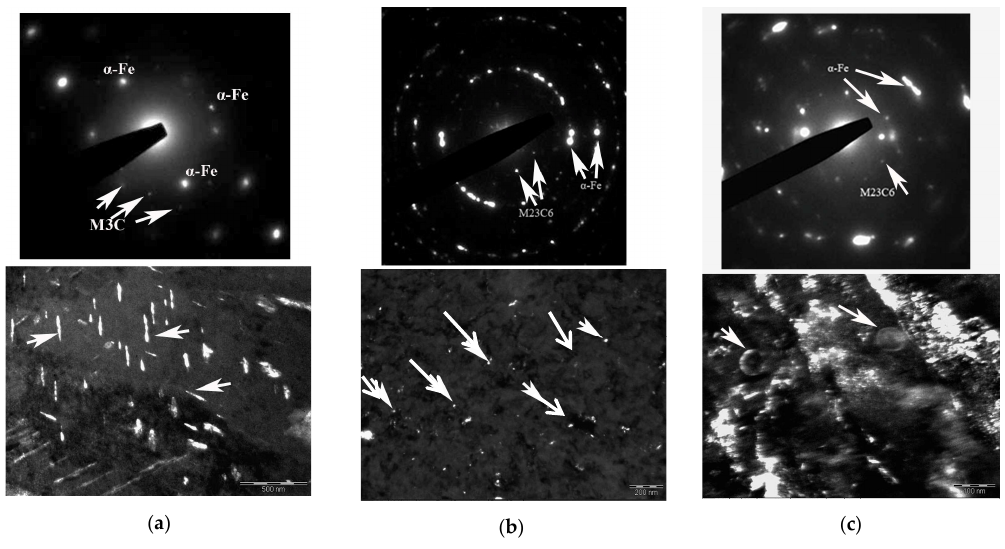
Figure 4. Diffraction patterns and dark-field TEM images showing carbides after various treatments: ( a ) T500, dark field in the spot (121) M 3 C; ( b ) T500 + HPT20, dark field in the spot (420) M 23 C 6 ; ( c ) T500 + HPT300, dark field in the spot (420)M 23 C 6 .